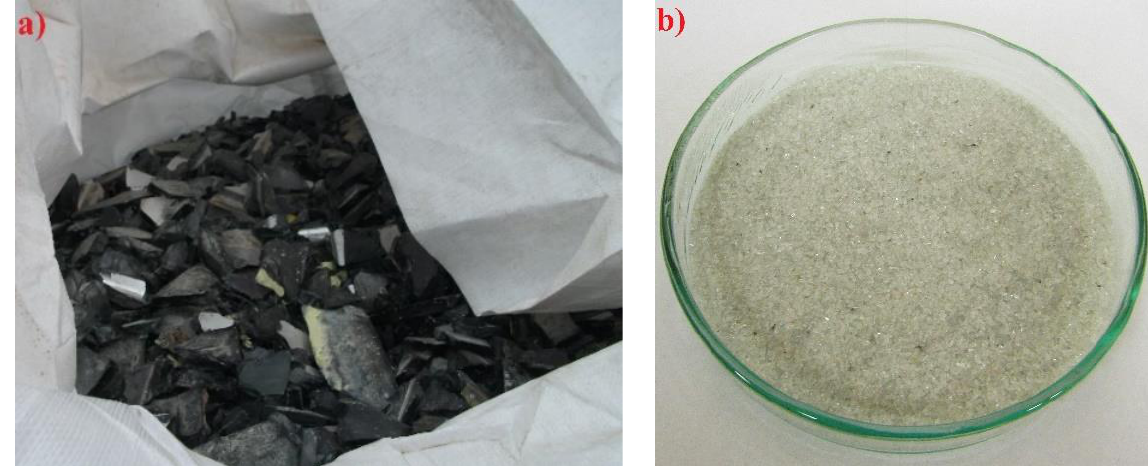
Figure 2. Shards of glass after recycling ( a ) and CRT glass 0.25/1.00 mm ( b ).